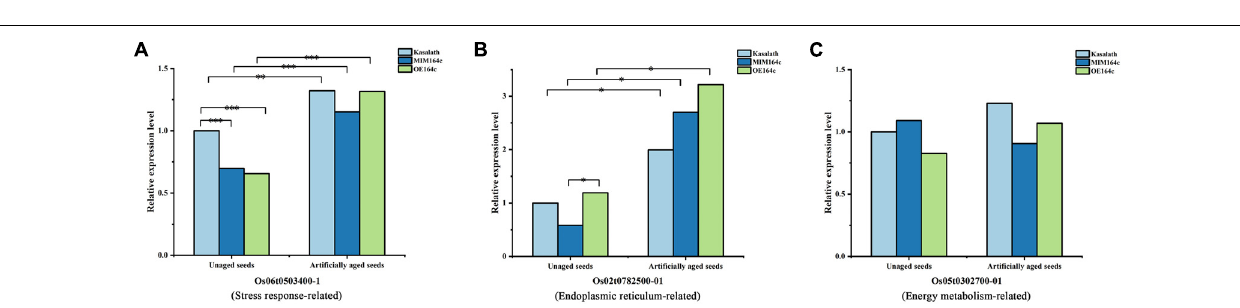
FIGURE 14 | Quantitative results of three key proteins in aged and unaged WT, ST, and OT seeds by MRM-MS. Data represent the mean of three technical replicates. A linear mixed-effects model was used to determine significant differences in protein expression levels among the three rice genotypes ( ∗ P < 0.05, ∗∗ P < 0.01, ∗∗∗ P < 0.001). The expression level of each protein in unaged WT seeds was defined as